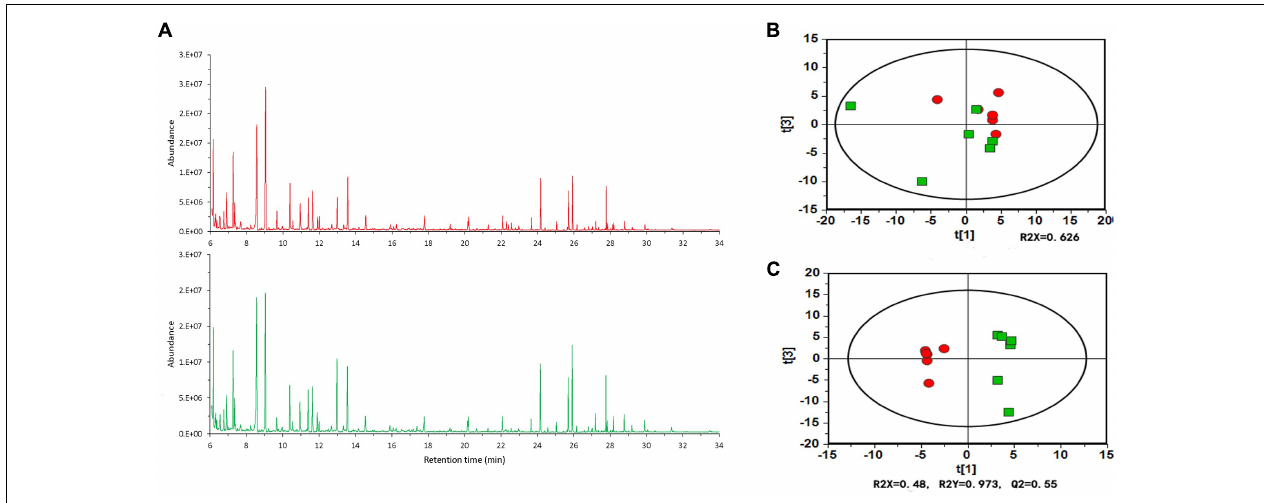
FIGURE 2 | GC-MS TIC chromatograms (A) , principal component analysis (PCA) (B) and orthogonal partial least-squares discrimination analysis (OPLS-DA) scores plots (C) of tomato root exudates induced by Bacillus cereus AR156 (red) and sterile water (green).